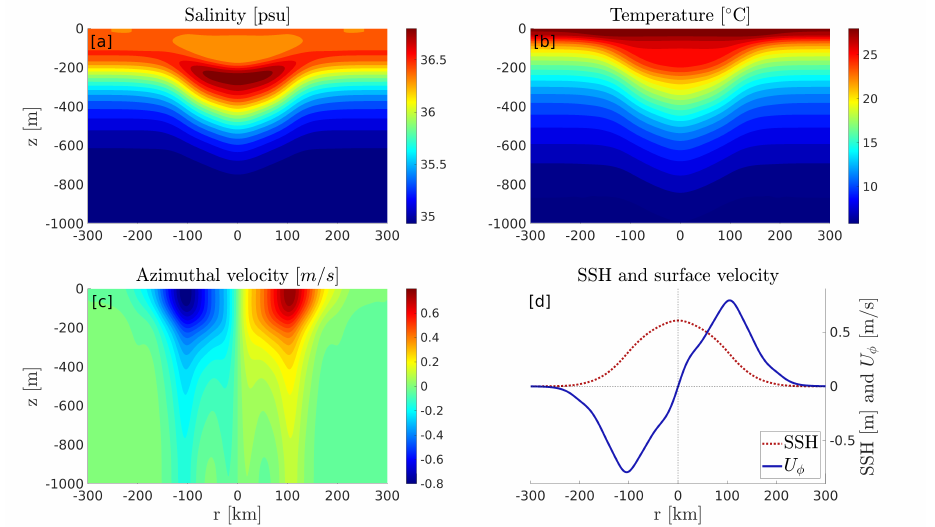
Figure 4. Properties of the idealized eddy used for validation of the relocation method. ( a ) Vertical section of salinity. ( b ) Same as panel ( a ) for temperature. ( c ): Same as panel ( a ) for azimuthal velocity. ( d ) Radial profile of SSH (red dotted line) and surface velocity (blue line) across the eddy. The mean virtual glider speed is set to 0.15 m s − 1 , with a random fluctuation ranging between − 0.075 m s − 1 and +0.075 m s − 1 . The eddy is drifting south-west at a speed